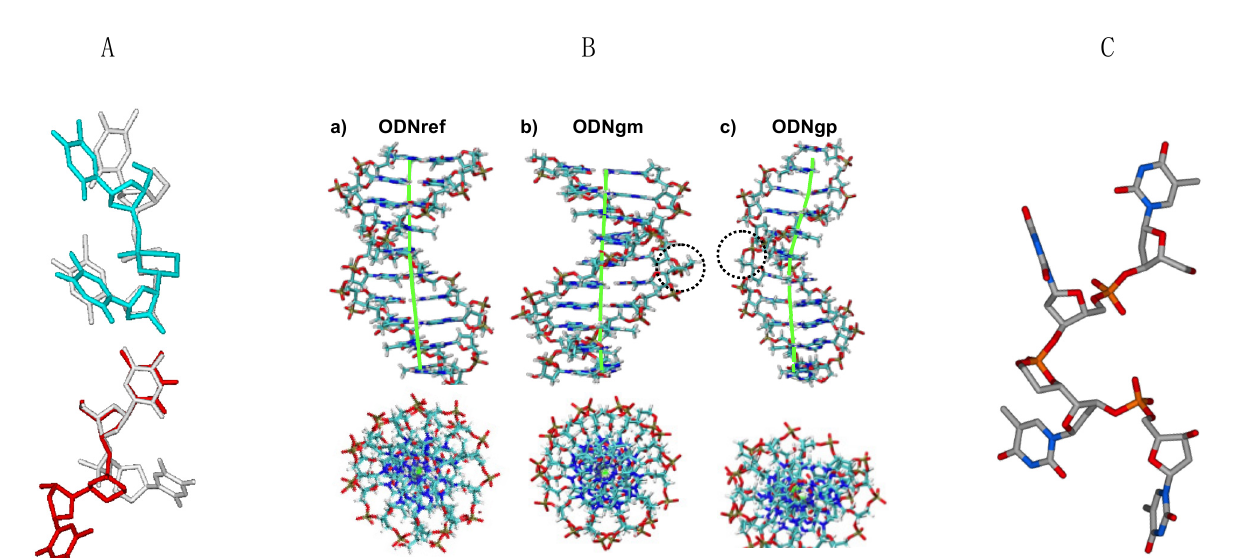
Figure 8. α , β -D-CNA within ON. ( A ) Superimposition of (g − , t) blue and (g + , t) red α , β -D-CNA with unmodified TpT. ( B ) Molecular dynamics simulation of unmodified dA 10 /dT 10 (ODNref), of α , β -D-CNA, featuring canonical torsional angle value within dA 10 /dT 10 (ODNgm), and of α , β -D-CNA featuring non-canonical torsional angle value within dA 10 /dT 10 (ODNgp). ( C ) α , β -D-CNA (g + , t) within tetrathymidilate.